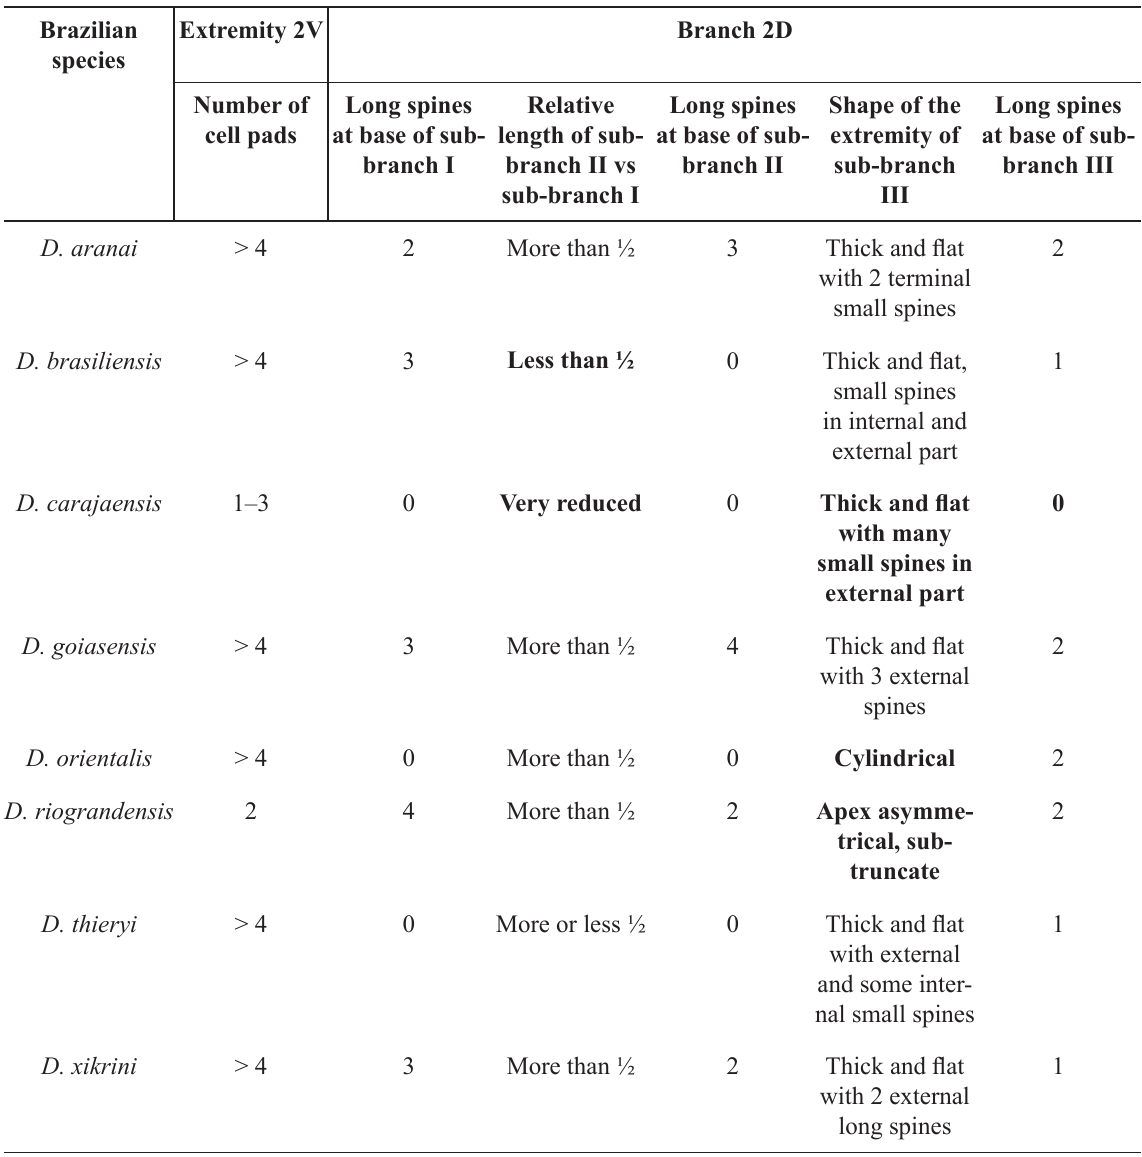
Table 2. Richness in Brazilian Dendrocephalus Daday, 1908. The bold characters correspond to characters allowing a direct determination of species